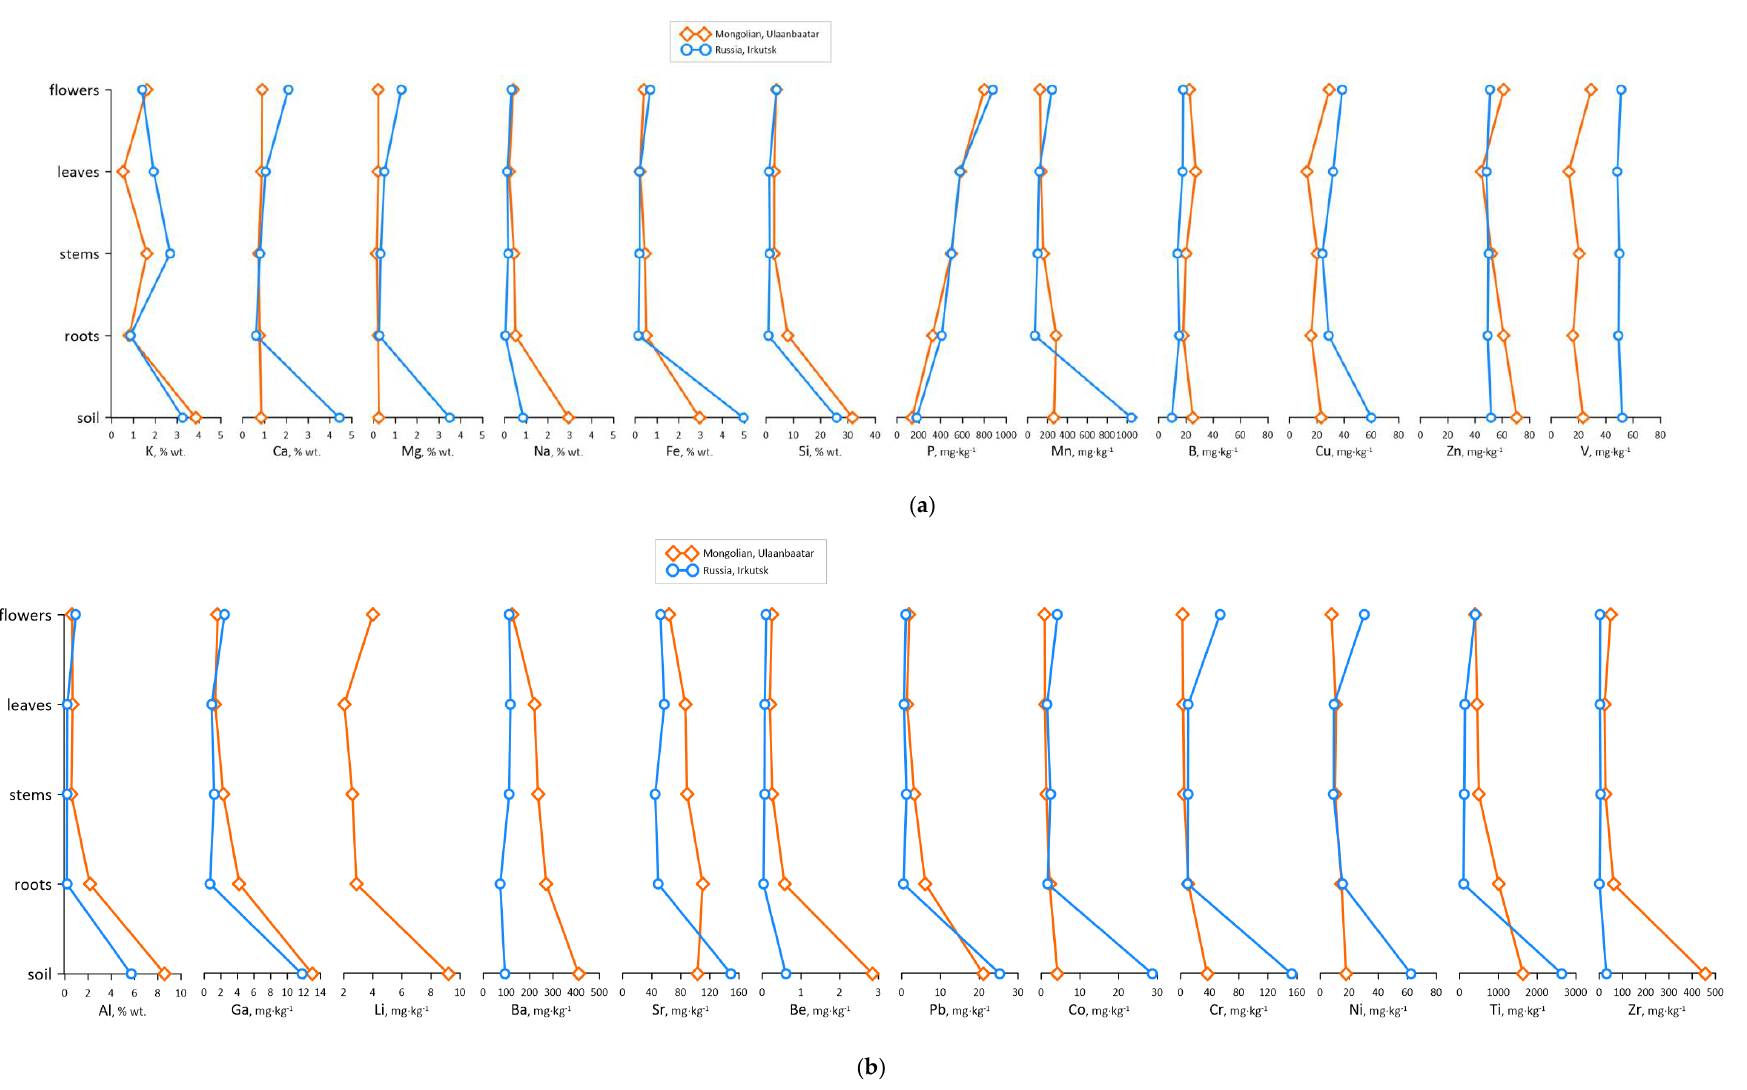
Figure 2. The elemental profiles: ( a ) essential elements; ( b ) toxic and sub-toxic (or sub-essential) elements.